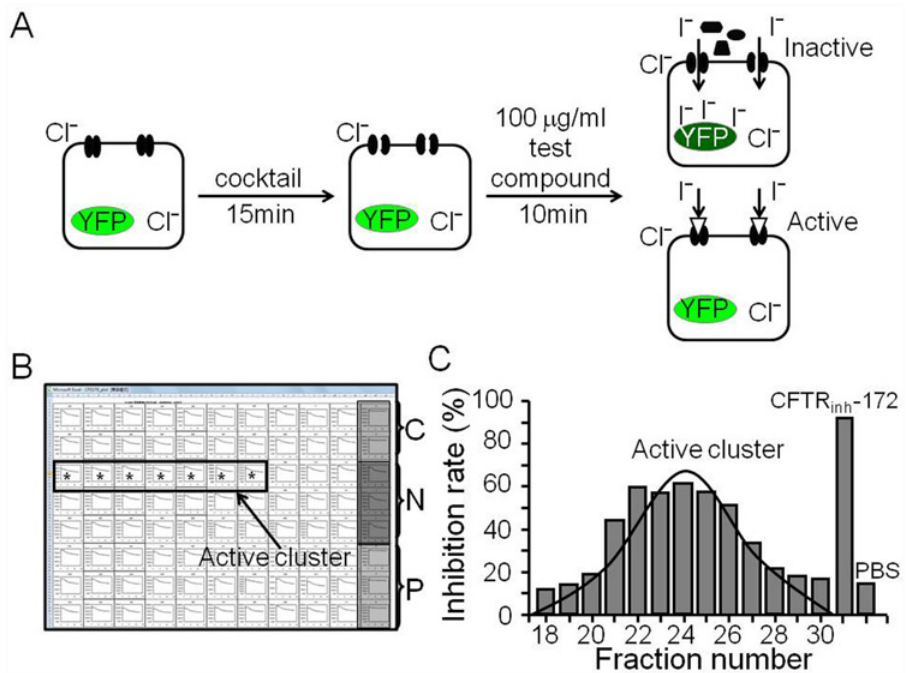
Fig 1. Inhibition of CFTR Cl (cid:1) channels by fractions from Rhodiola kirilowii (Regel) Maxim. A. Principle of cell-based fluorescence assay. FRT cells stably co-transfected with human CFTR and YFP-H148Q were prestimulated with a cocktail (5 μ M FSK, 100 μ M IBMX and 25 μ M GEN) for 10 min before addition of a test sample to final concentration of 100 μ g/ml. CFTR-mediated I (cid:1) influx was measured from the kinetics of decreasing YFP-H148Q fluorescence in response to addition of I (cid:1) solution. B. Time-course fluorescence data from a 96-well microplate of CFTR-expressing FRT cells. Controls (C: PBS; N: cocktail; P: cocktail plus 20 (cid:1) influx (representing CFTR μ M CFTR inh -172) are shown on the right. Asterisk show wells with decreased I inhibition). C. % inhibition rate of the active wells indicated Gaussian distributions of the active sites.